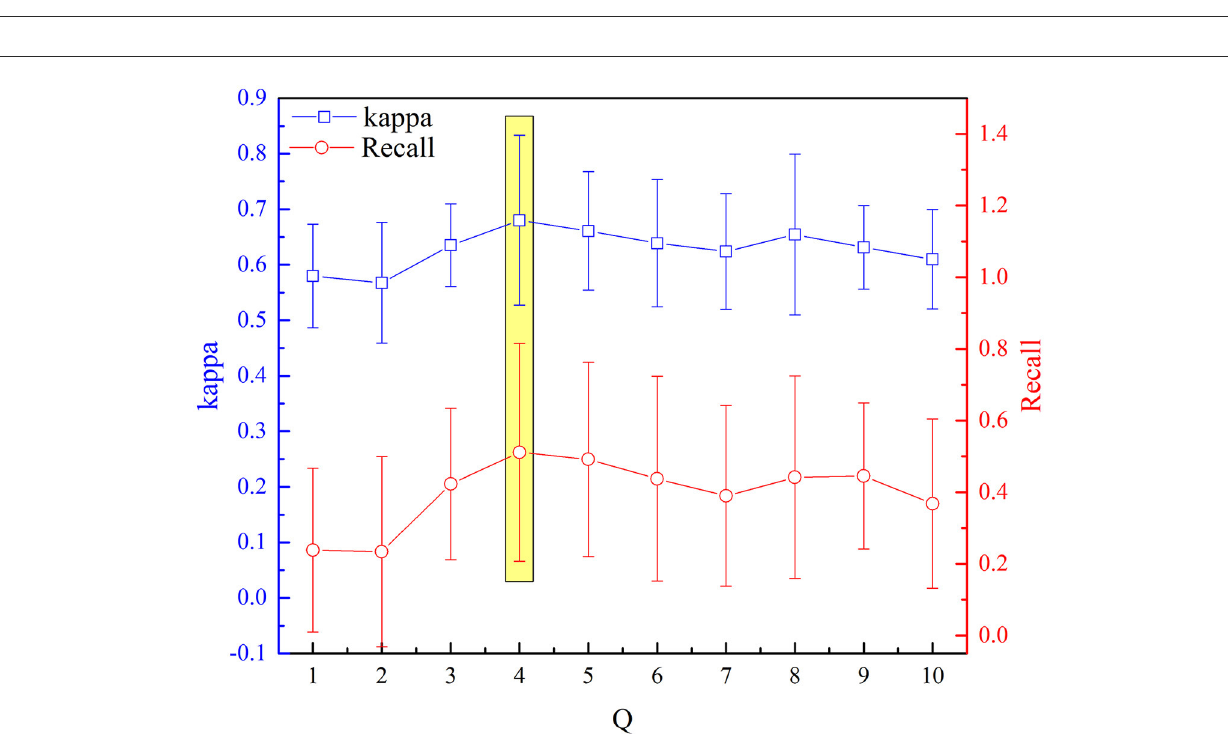
FIGURE8 Variation of kappa and recall value with Q for the detection of k-complexes.